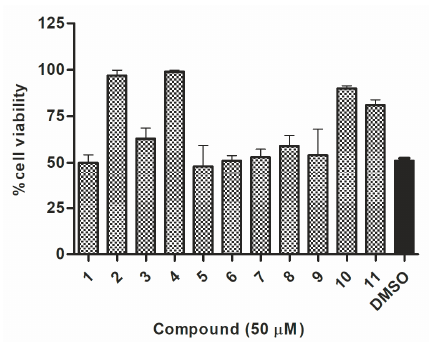
Figure 2. The effect of compounds 1 – 11 on the tick-borne encephalitis virus (TBEV)-induced cytopathic effect in A549 cells. A549 cells were infected with TBEV Hypr strain at a multiplicity of infection (MOI) of 0.1 and treated with 50 µM of compounds or DMSO (positive control). Cell death was measured and expressed as the percentage of cell viability 96 h post-infection (p.i.). Error bars indicate standard deviations from three experiments.